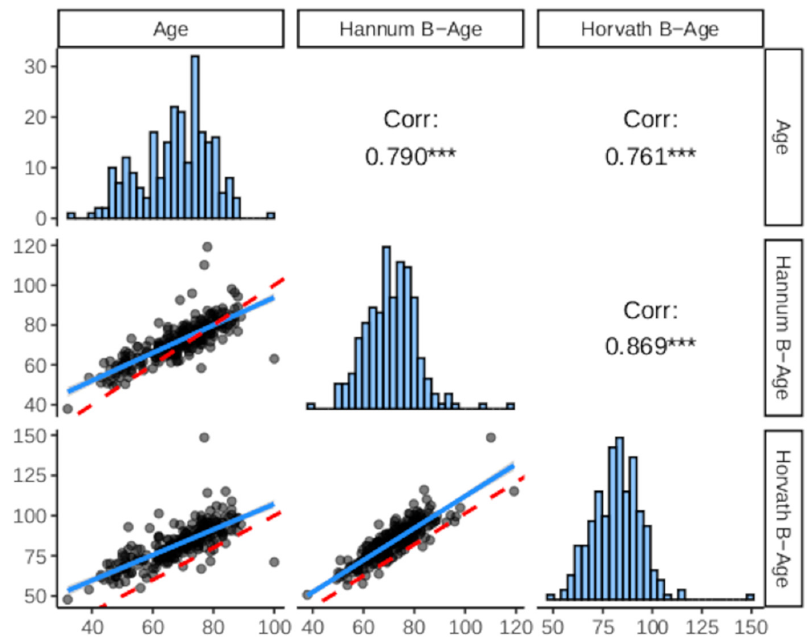
Figure 1. Correlation between biological age estimations and chronological age. Lower and upper panels represent the correlation between biological age estimations (Hannum and Horvath formulas) and chronological age.The red-dashed lines in the lower panels represent the “perfect” concordance between variables, while the blue straight lines correspond to the true association obtained from a linear fit. Diagonal panels show the histograms from each variable. *** p -value < 0.001.